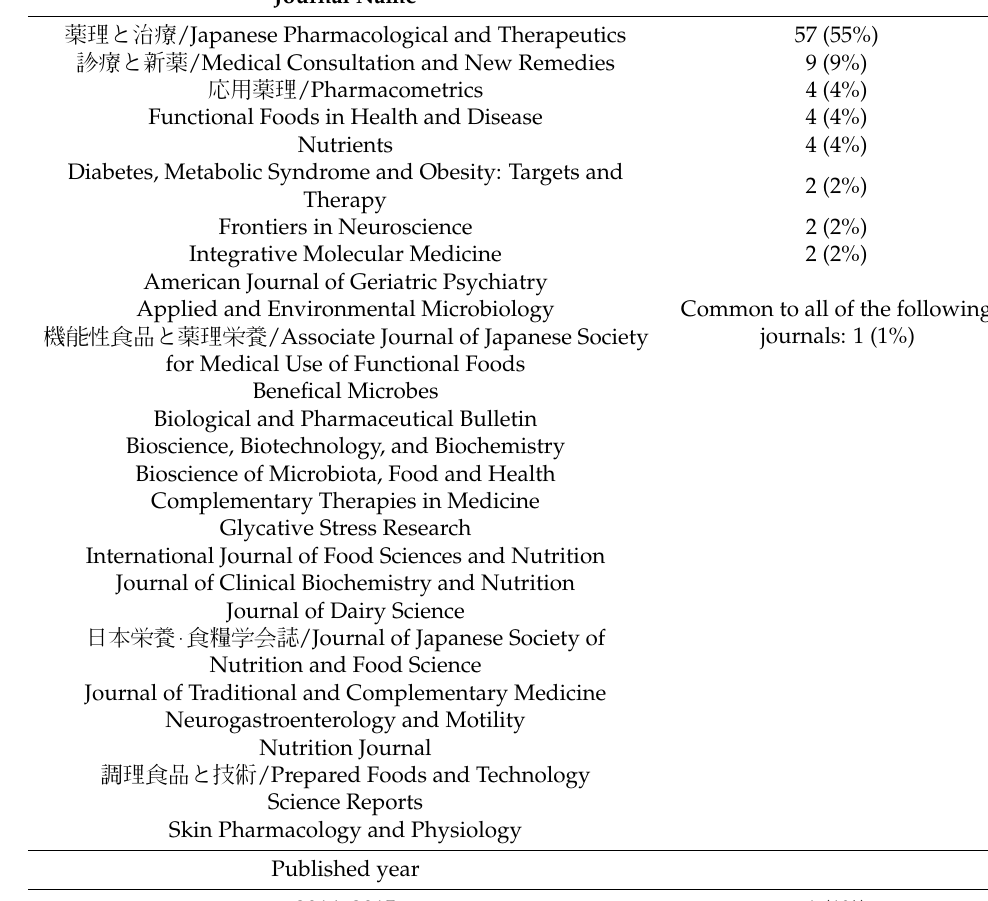
Table 2. Published journal’s